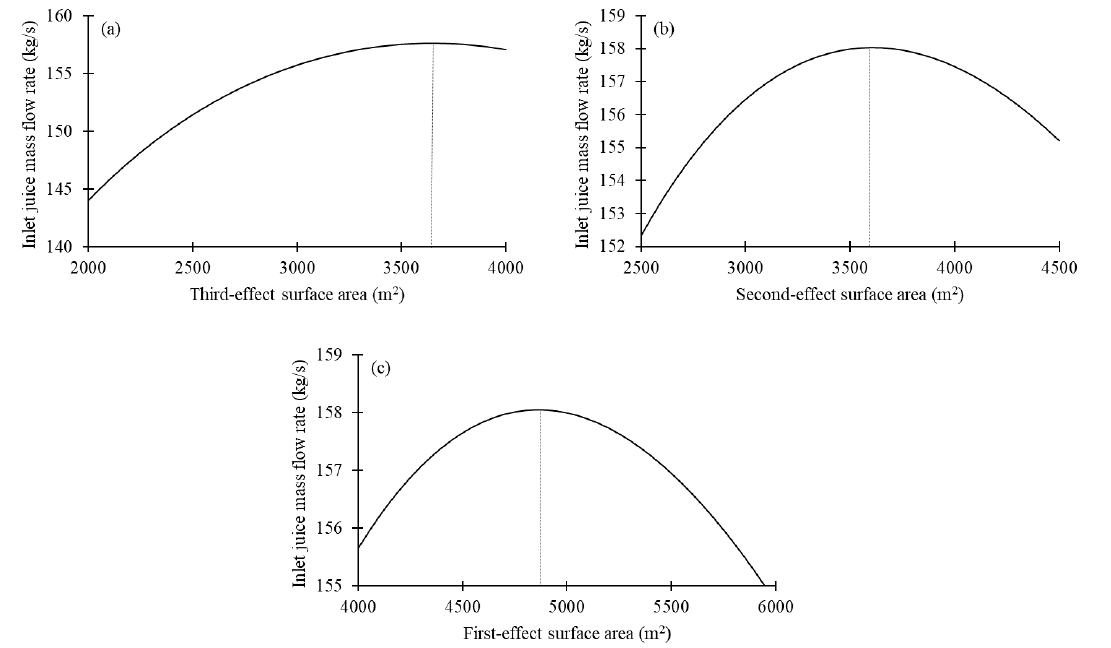
Figure 5. Procedure for finding the optimum surface area distribution in the backward - feed multiple - effect evaporator : ( a ) finding the optimum third - effect surface area ( A 3 ) , ( b ) finding the optimum second - effect surface area ( A 2 ) , and ( c ) finding the optimum first - effect surface area ( A 1 ).